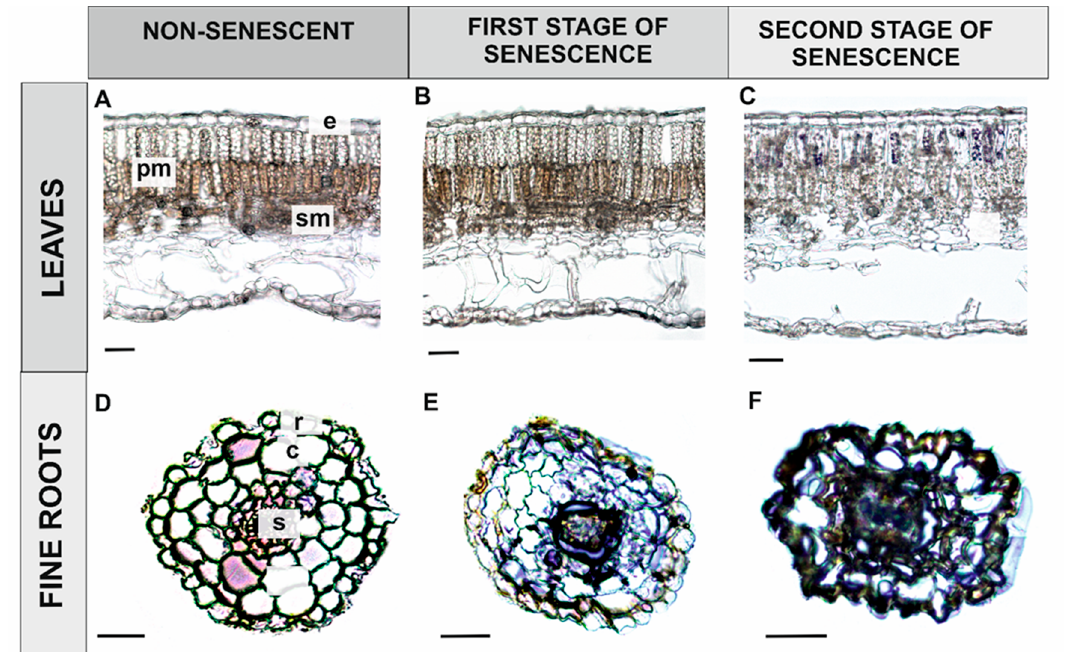
Figure 4. Localization of superoxide (dark blue dye) during leaf and fine root senescence in black cottonwood ( Populus trichocarpa ). Control leaf ( A ), first stage of leaf senescence ( B ), second stage of leaf senescence ( C ), fine root control ( D ), first stage of fine root senescence ( E ), second stage of fine